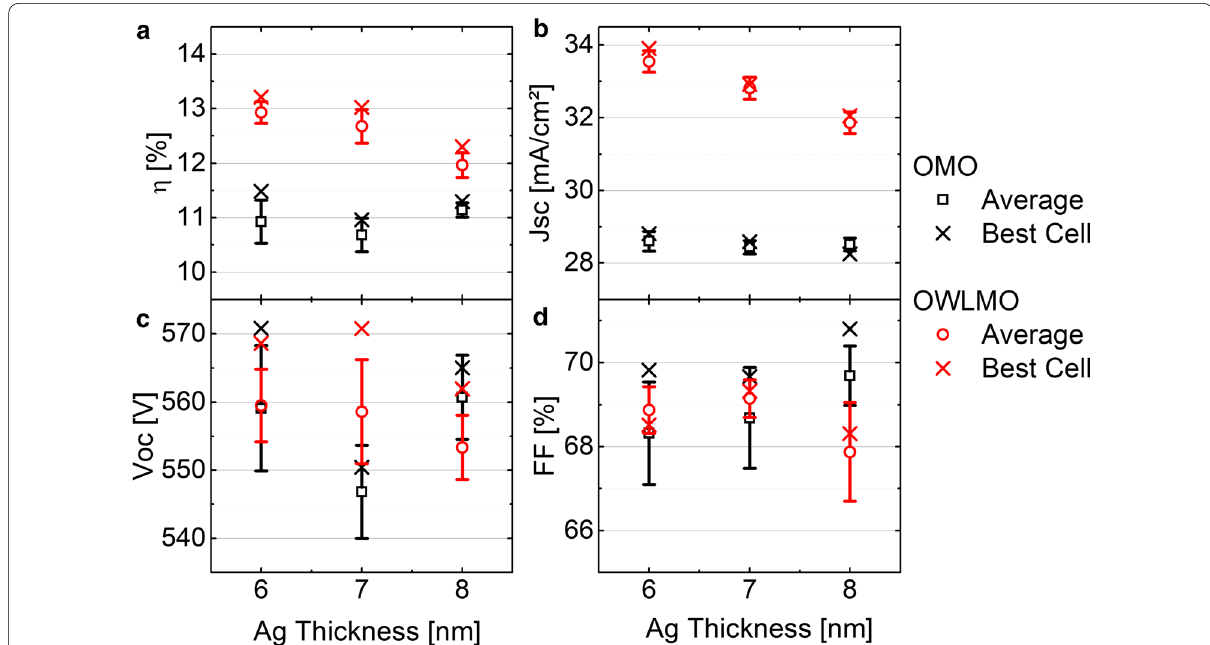
Fig. 4 Comparison of the cell performance parameters efficiency ( a ), short‑circuit current density ( b ), open‑circuit voltage ( c ) and fill factor ( d ). The open symbol indicates the average of a set of nine cells and the cross the value of the best performing